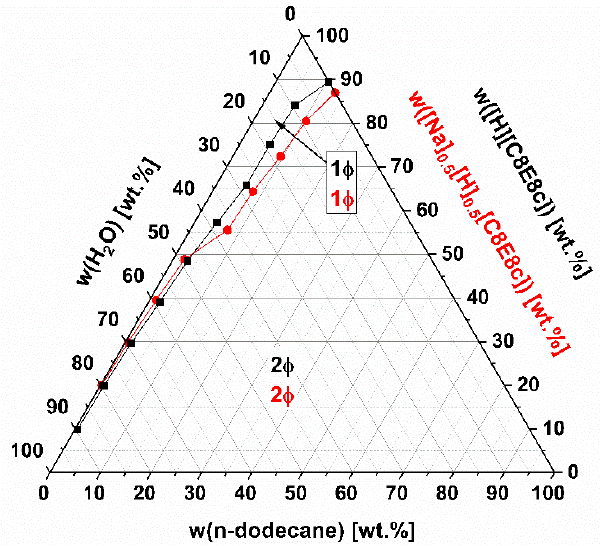
Figure 6. Ternary phase diagrams of [H][C8E8c]/H 2 O/n-dodecane ( ) and [Na] 0.5 [H] 0.5 [C8E8c]/H 2 O /n-dodecane ( ) at a temperature of 23 °C (±1 °C). Concentrations are given in wt.%. The precision in w(n-dodecane) is usually ±0.5 wt. %, whereas the deviation of the other weights is negligible; 1 ϕ denotes a monophasic system, and 2 ϕ , realms of existence of two liquids in equilibrium.